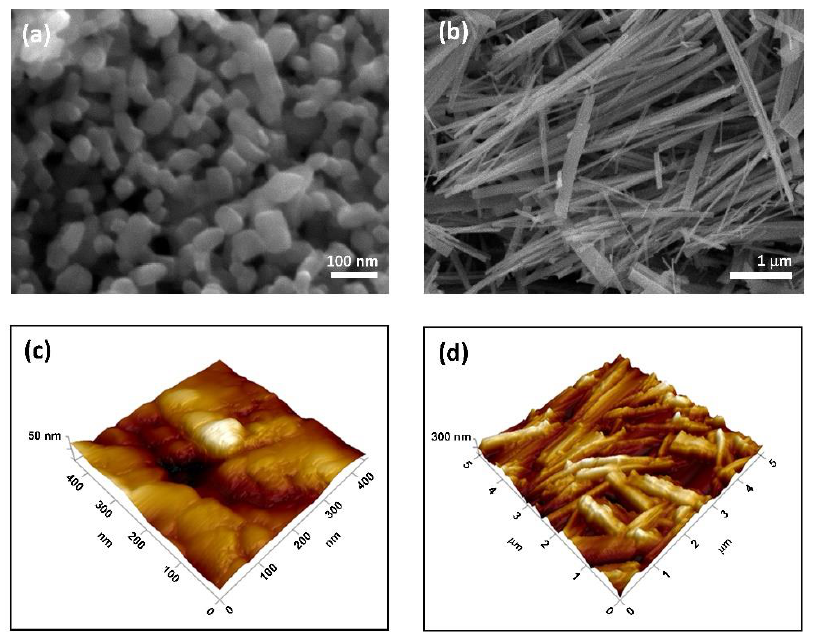
Figure 2. Scanning electron microscopy (SEM) ( a , b ) and atomic force microscopy (AFM) phases ( c , d ) micrographs of TiO 2 nanoplates ( a , c ) and TiO 2 nanowires ( b , d ). The specific surface areas were 24.70 m 2 g − 1 and 21.49 m 2 g − 1 for TiNPls and Table 1. Hydrodynamic diameter ( d h ) and zeta potential ( ζ ) of TiO 2 nanoplates (TiNPls) and nan- owires (TiNWs) suspended in corrected simulated body fluid (c-SBF) and anionic reactant solution